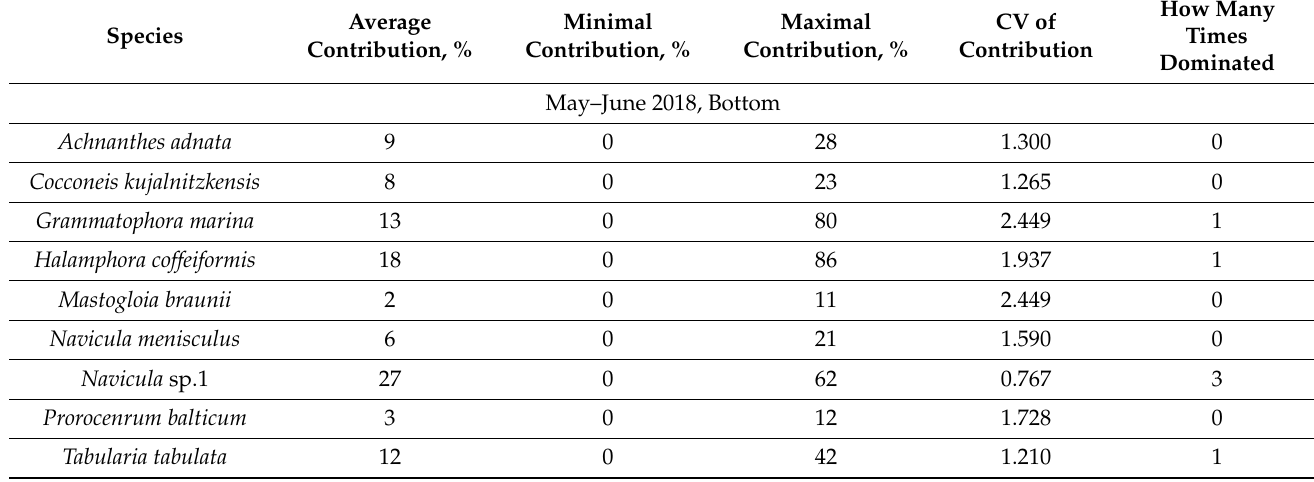
Table 5. The contribution of the different species in total microalgae abundance and their frequency of dominance in Bay Sivash